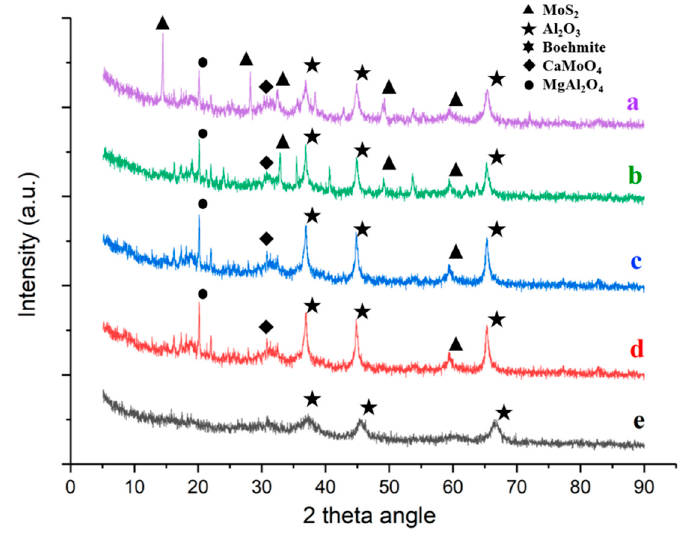
Figure 7. XRD patterns of CATs served for different time ( a ) 4 years; ( b ) 3 years; ( c ) 2 years; ( d ) 1 year; ( e ) as-prepared.